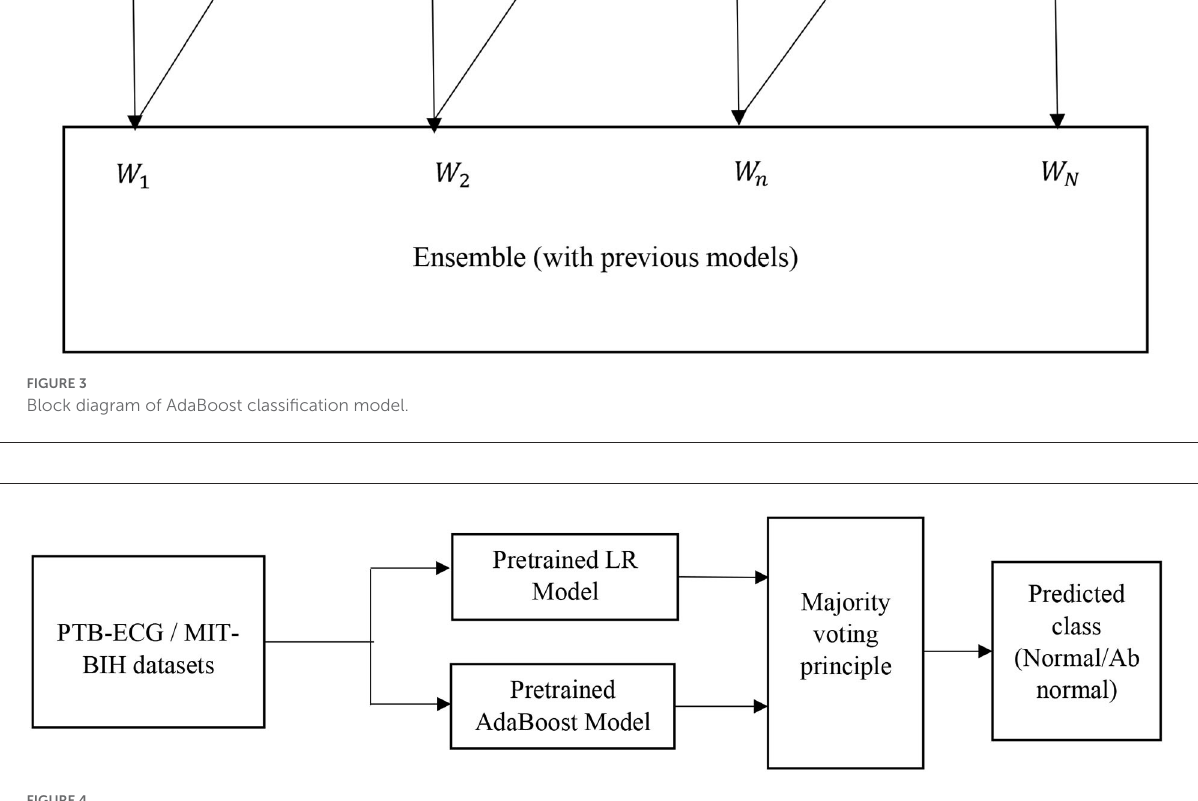
FIGURE4 Block diagram of LR-AdaBoost ensemble